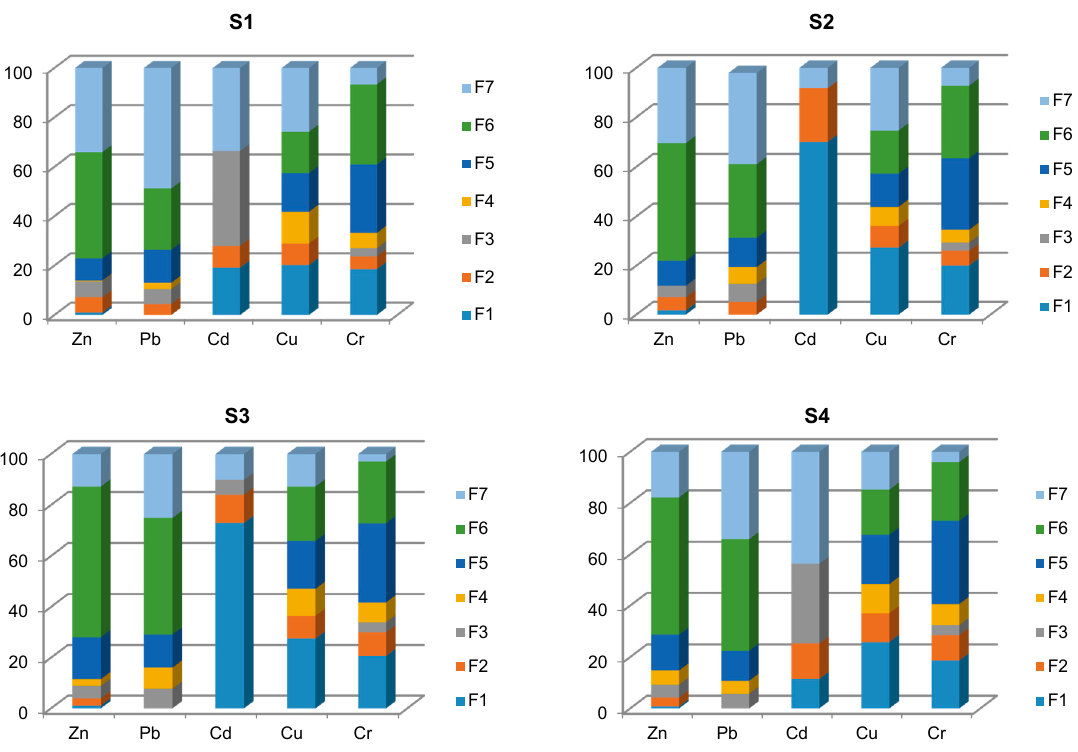
Figure 3. Sequential extraction of fly ashes after hard coal combustion (%).